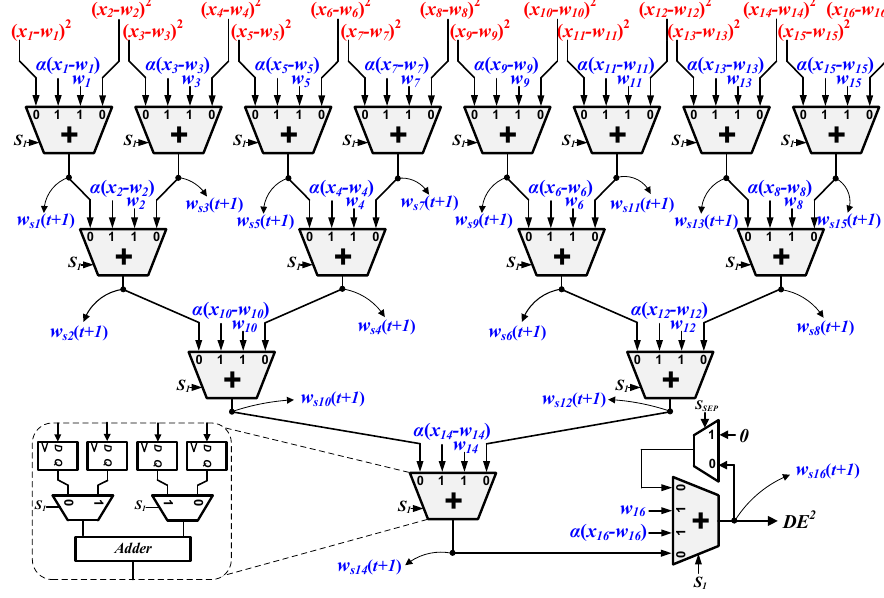
Figure 3. The basic architecture of reconfigurable complete-binary-adder-tree.